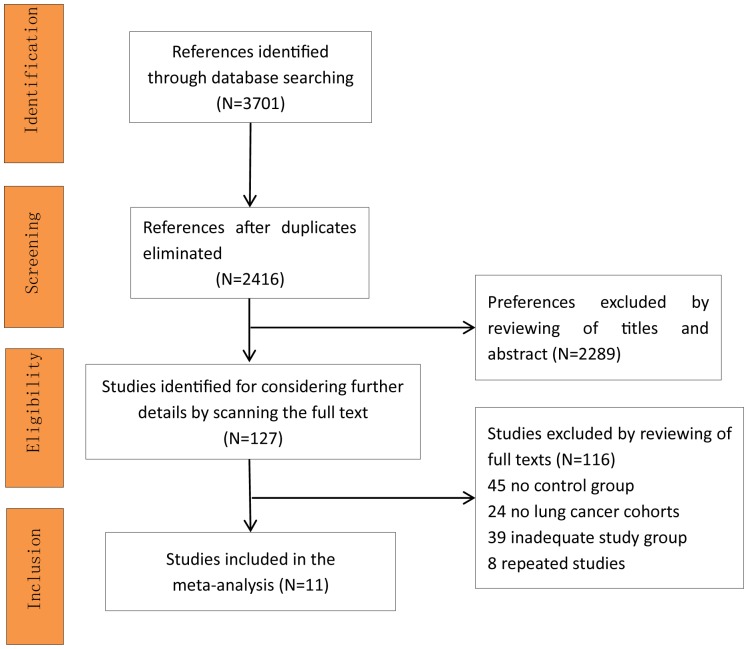
Preferences selection flow diagram.